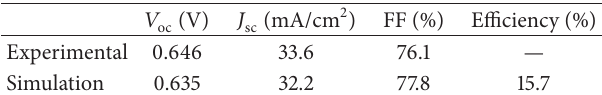
Table 2: Results from simulation compared with experimental data